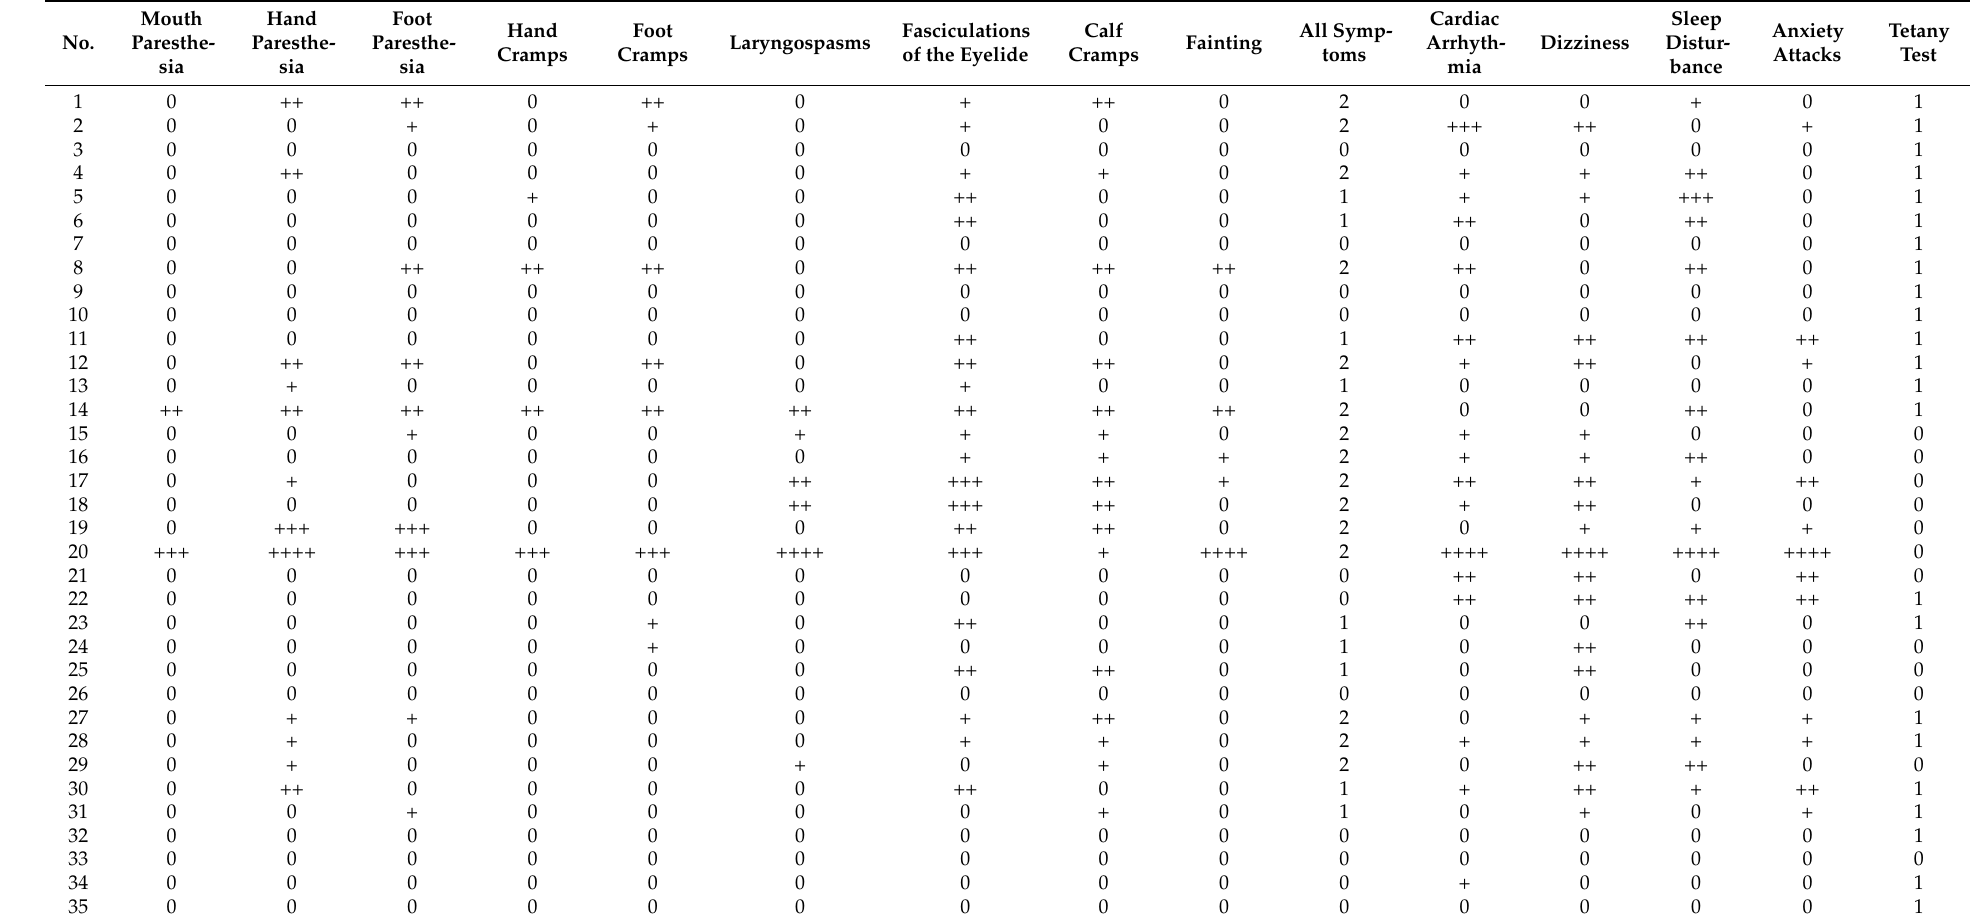
Table 3. Clinical and electrophysiological characteristics of the study group ( n = 35). Clinical complains: 0—absent, +—several times a year, ++—several times a month, +++—several times a week, ++++—every day. All symptoms: 0—no complains, 1—1–2 types of ailments, 2—more than 2 types of ailments. Tetany test result: 0—negative,